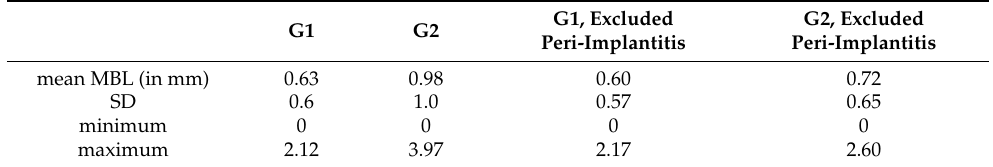
Table 1. Marginal bone loss (MBL) for Group G1 and Group